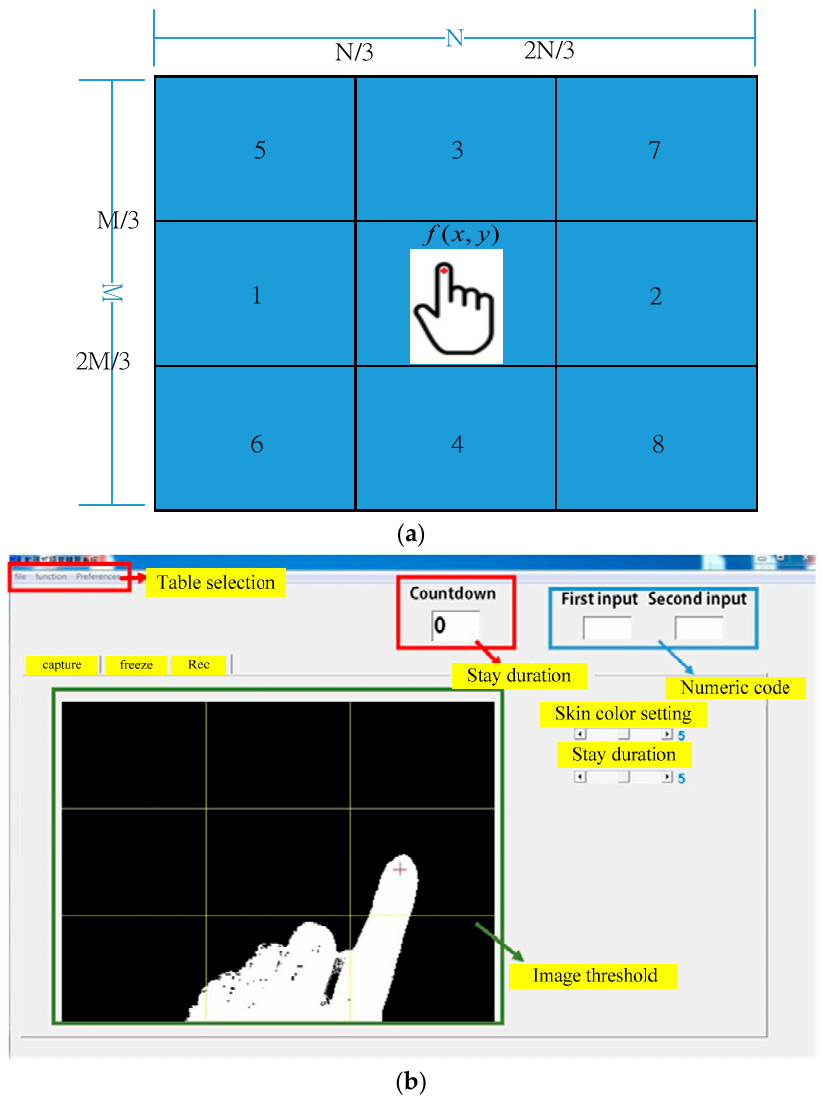
Figure 13. The numeric DT-HMIS using finger gesture recognition ( a ) eight region ( b ) screen of the